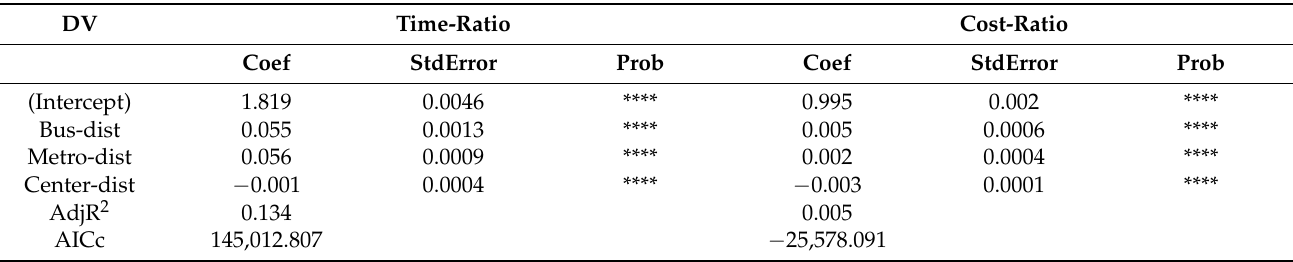
Table 3. Results of the OLS regression.